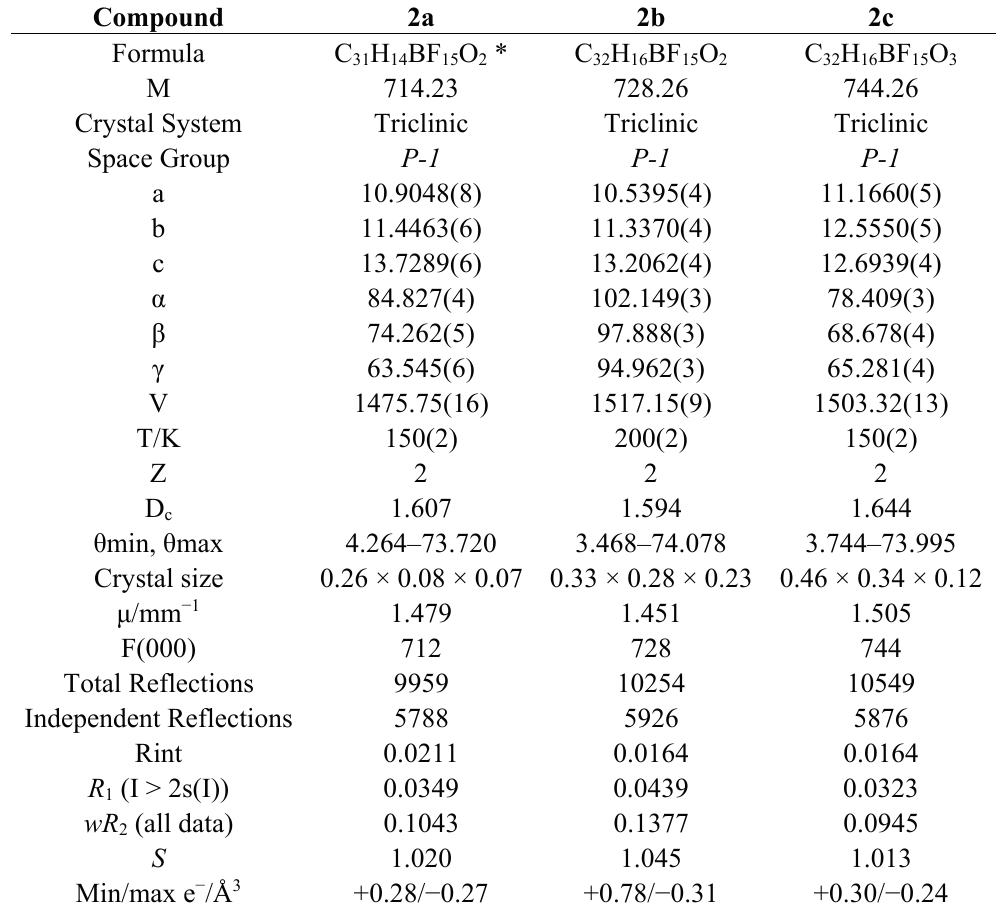
Table 4. Crystallographic data for compounds 2a – 2c